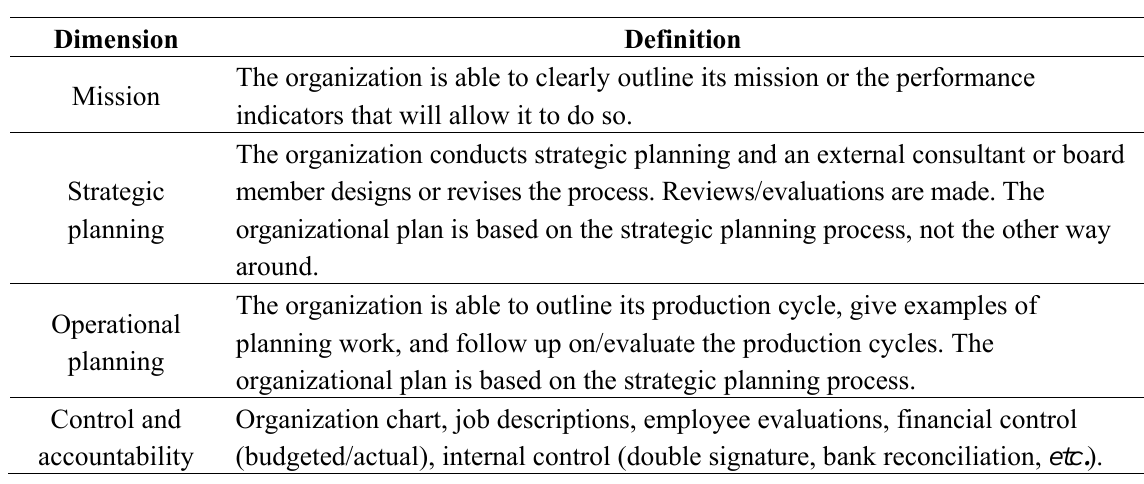
Table 8. Definitions of internal